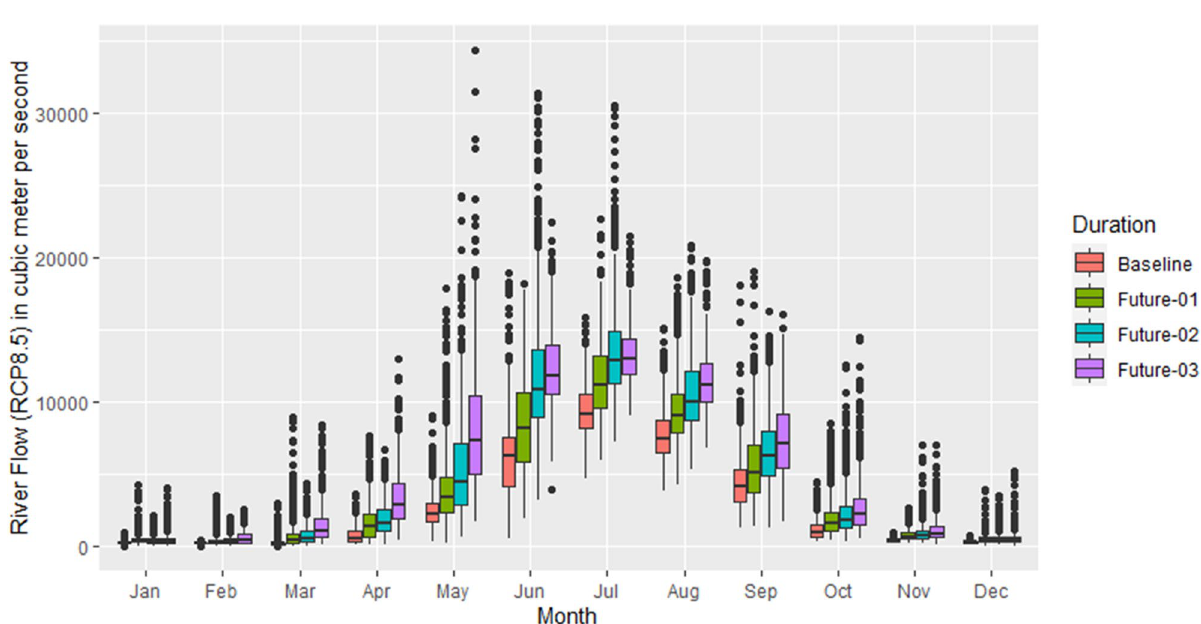
Figure 7. Similar to Fig. 6 but using the RCP8.5